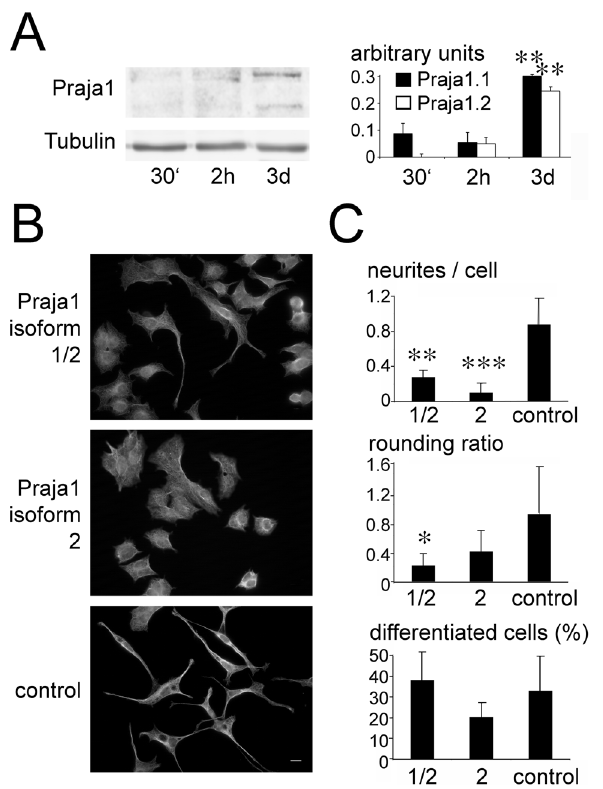
Figure 4. Praja1 in neuronal differentiation of PC12 cells. (A) Immunoblot analysis reveals the increased expression of endogenous Praja1 after 3 days of NGF treatment. Expression levels (normalized for tubulin) are increased more than 3-fold compared to the initial phase of outgrowth ** p , 0.01, compared to 30 min after stimulation. (B) shows representative examples of PC12 cells stably expressing either EGFP::Praja1.1/2, EGFP::Praja1.2 alone, or only EGFP as control. Cells were stained with an anti-tubulin antibody to visualize their neurites. Figure 5. Polyubiquitination and NRAGE expression levels in PC12 cells. (A) Immunoblot analysis reveals an increase of total protein ubiquitination in cells expressing EGFP::Praja1.1/2 (lanes 3&4) or only EGFP::Praja1.2 (lanes 5&6) compared to EGFP transfected controls